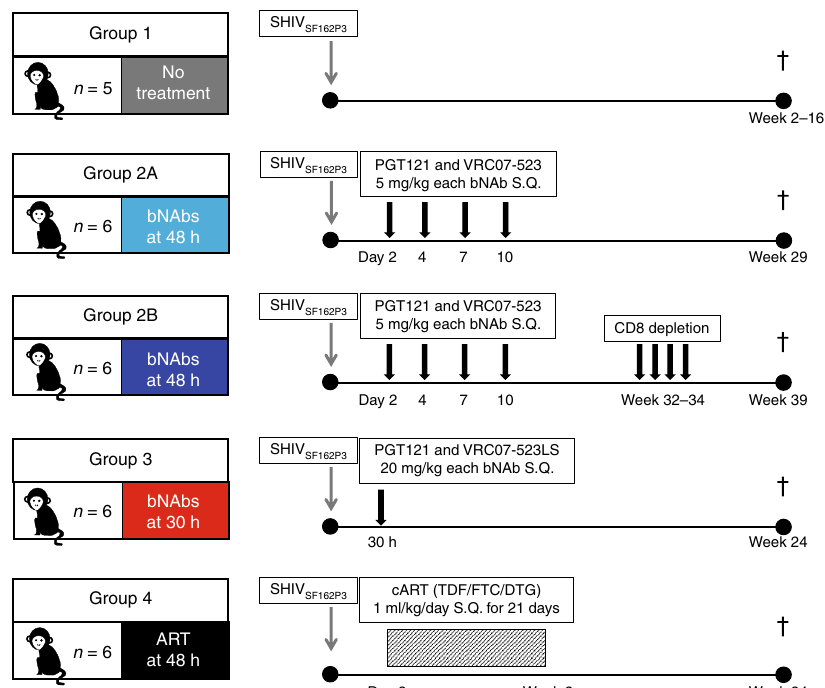
Fig. 1 Study design. One-month-old infant rhesus macaques negative for Mamu-B*08 and Mamu-B*17 alleles were randomly assigned to groups. All animals were exposed to a single high dose SHIV SF162P3 challenge by atraumatic oral inoculation. S.Q., subcutaneous delivery. TDF, tenofovir disoproxil fumarate (5.1 mg/kg). FTC, emtricitabine (40 mg/kg). DTG, dolutegravir (2.5 mg/kg). Gray arrows indicate SHIV infection. Black arrows indicate bNAb treatments. Rectangle with diagonal stripes indicates duration of daily ART treatment. Dagger indicates time of necropsy. Group colors are consistent throughout the manuscript. The number of animals (N) is indicated next to the monkey cartoon in each